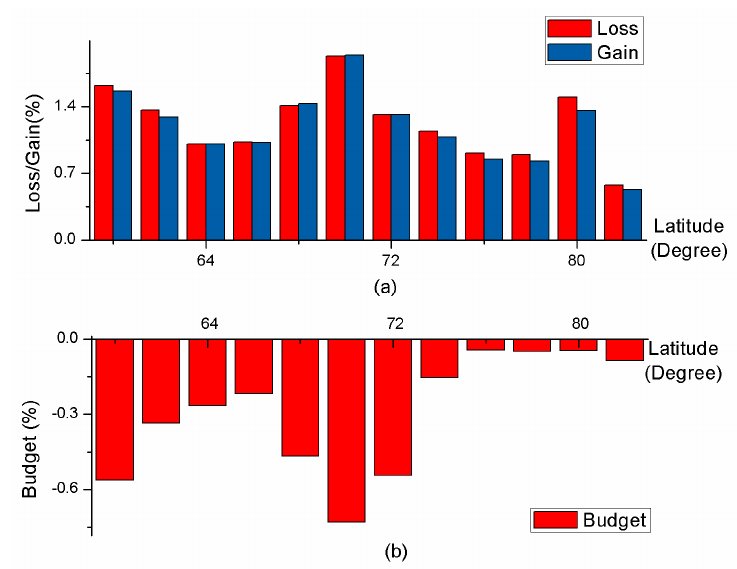
Figure 6. The dynamics of inland water according to the latitude (the figure showed the yearly average dynamics of water with latitude), the Figures ( a ) and ( b ) respectively repercent changing percentage of loss/gain and budget over the latitude.